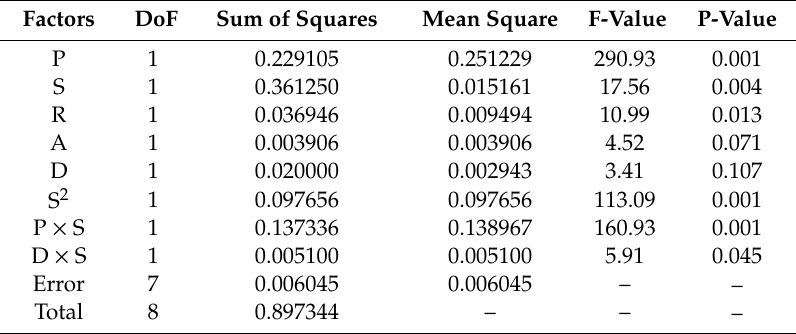
Table 5. ANOVA table for case depth at the tip of the splines (H T ).